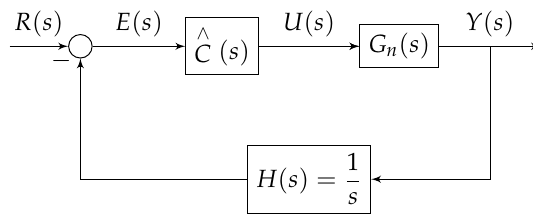
Figure 5: Closed-loop HOCIP with an FOPID controller.